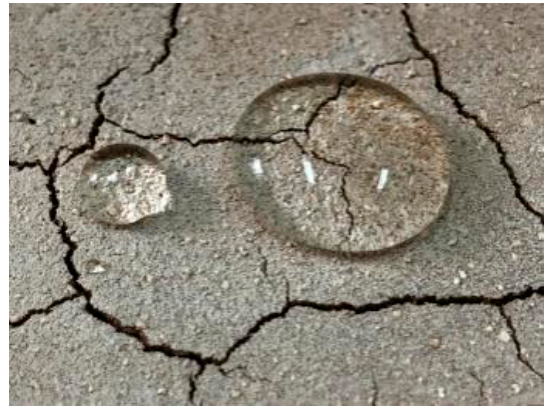
Figure 9. Soil sample Hydrophobic rendering.